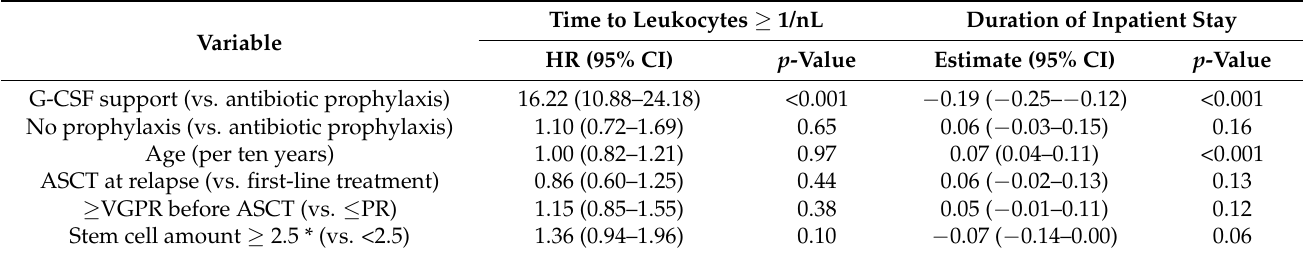
Table 3. Results of the cox regression analysis on the impact of the anti-infective strategies (I)–(III) on the time from leukocytes <1/nL to ≥ 1/nL and results of the multivariate linear regression analysis on the duration of inpatient